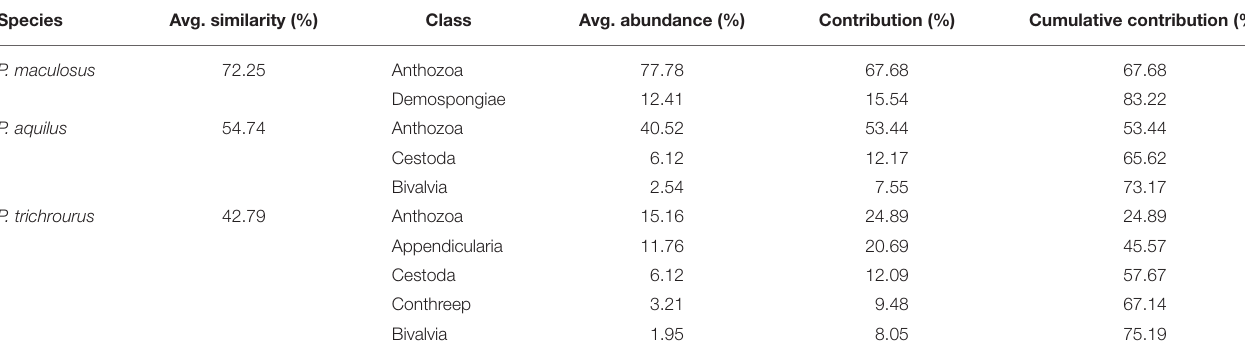
TABLE 1 | Results of SIMPER analysis of similarity within each species group showing top stomach content contributors (cut off 70%). Species Avg. similarity (%) Class Avg. abundance (%) Contribution (%) Cumulative contribution (%) P.